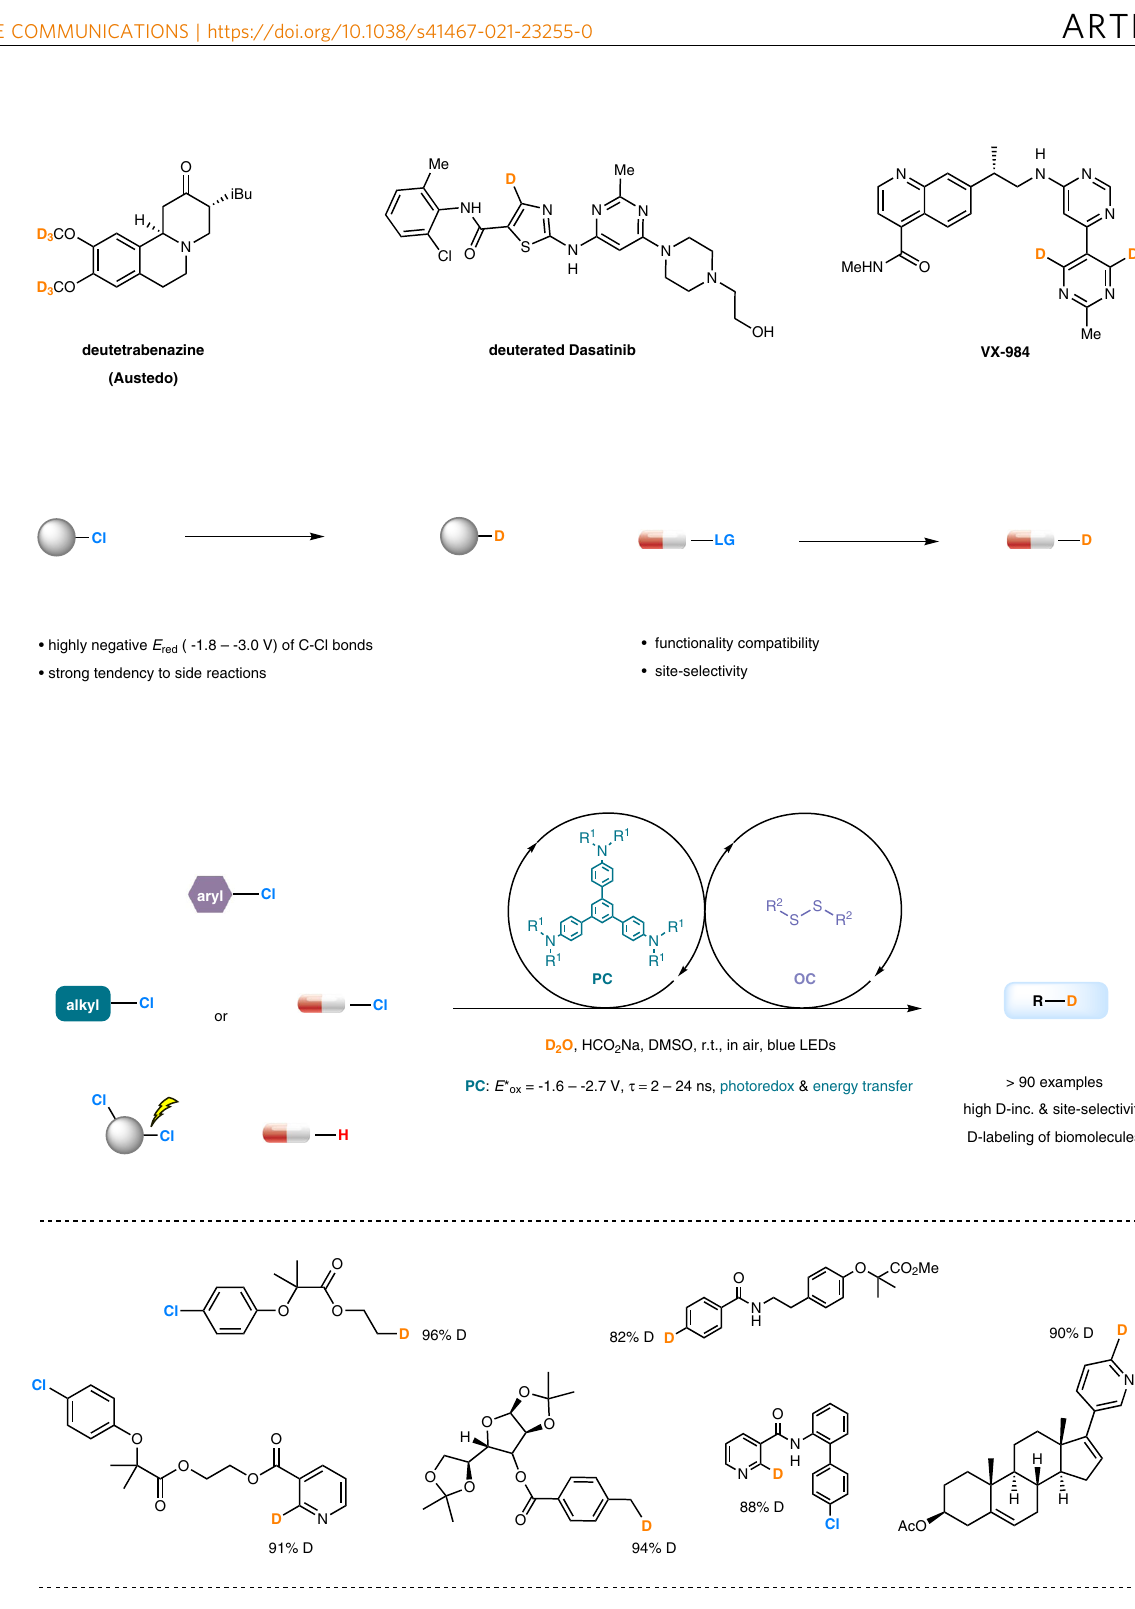
Fig. 1 Overview of this work. a Deuterated drug molecules. b Challenges in deuterodehalogenation of organic chlorides and its application to drug labeling. c This work: organophotocatalytic selective deuterodehalogenation of aryl or alkyl chlorides. LG, leaving group; PC, photocatalyst; OC, organocatalyst; r.t., room temperature; D-inc., deuterium incorporation; DMSO, dimethyl Reaction scope of aryl chlorides and other halides . With the ( 2b , 2c ) or an electron-withdrawing group ( 2d – 2f ) were formed within 10 – 12 h from the chlorobenzene derivatives (67 – 86% optimal conditions in hand, the substrate scope of the photo- yield, 83 – 97% D-inc.). 1-Chloro-4-methoxybenzene failed to catalytic deuterodehalogenation of aryl chlorides was investigated provide the desired product ( 2g ) when using PC1 as the (Fig. 4). Products bearing a phenyl substituent ( 2a ), a fused ring